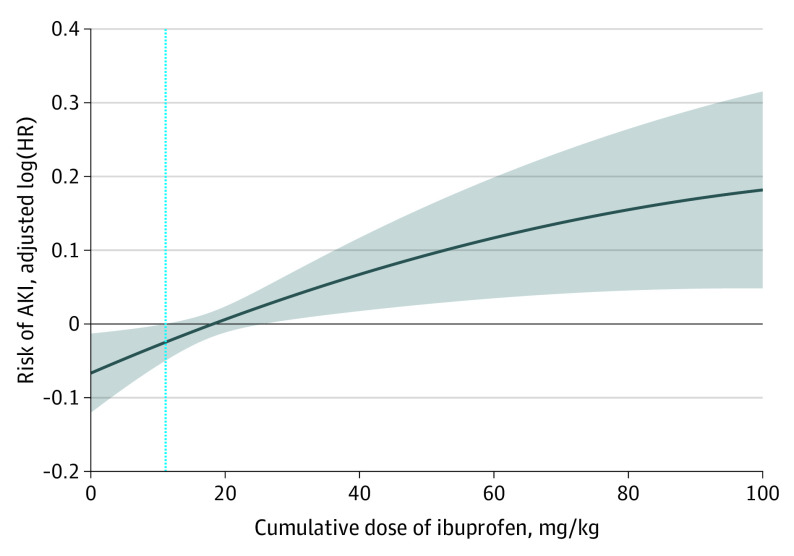
Dose-Response Curve of the Risk of Hospital-Acquired Acute Kidney Injury (AKI) and the Cumulative Dose of IbuprofenHazard ratio (HR) was adjusted for covariates in the main text. The dotted vertical line indicates the median cumulative dose of ibuprofen.